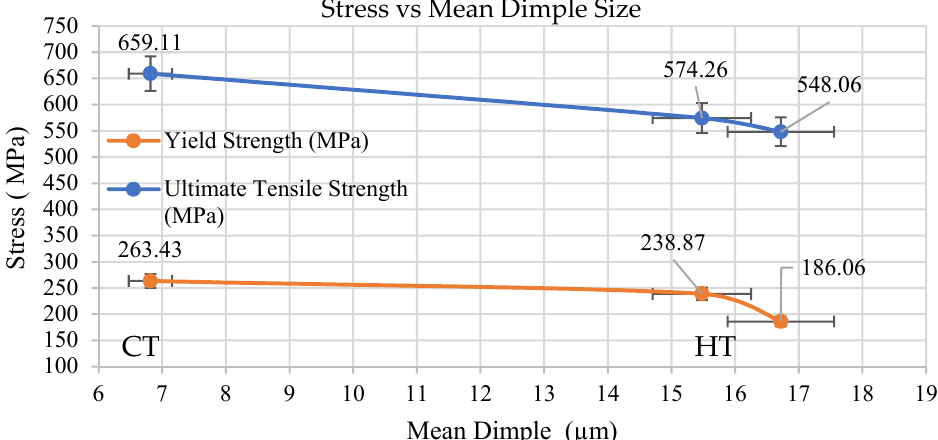
Figure 19. Mean dimple size vs stress.